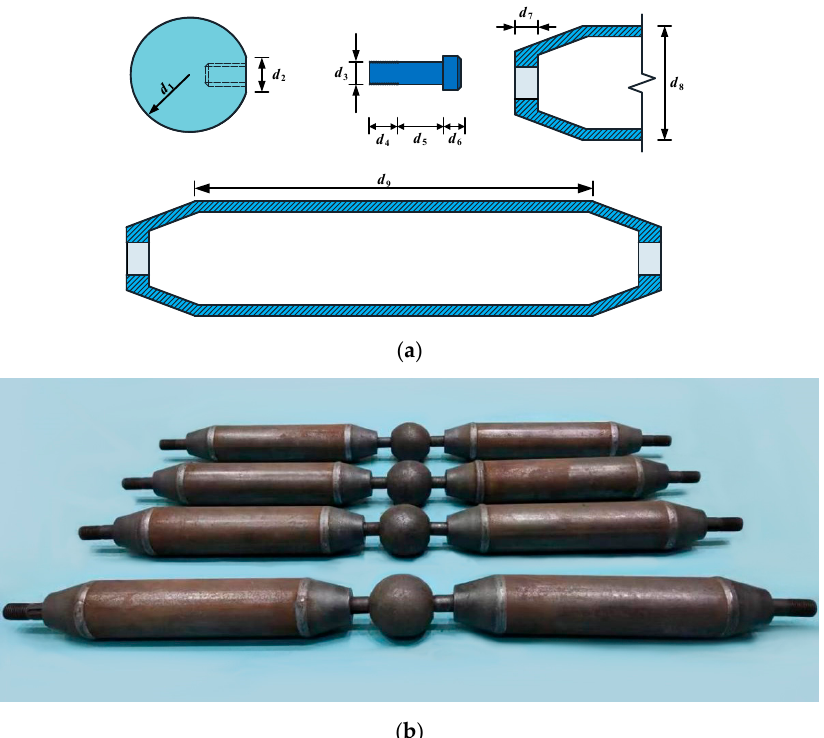
Figure 3. Bolt-sphere joints with members: ( a ) schematic of the component dimensions; ( b ) typical bolt-sphere joints.